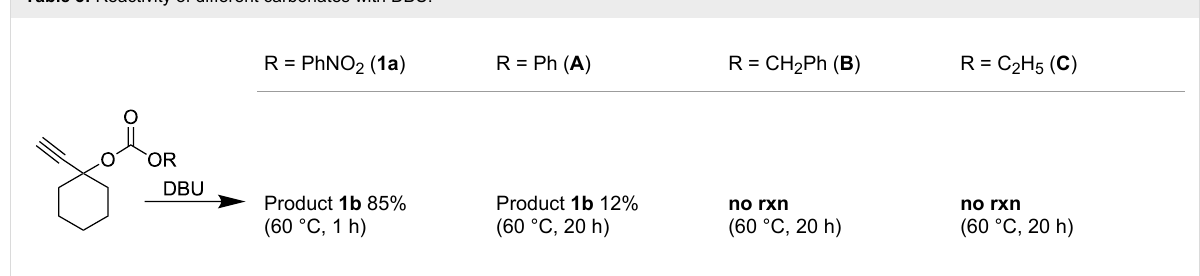
Table 3: Reactivity of different carbonates with